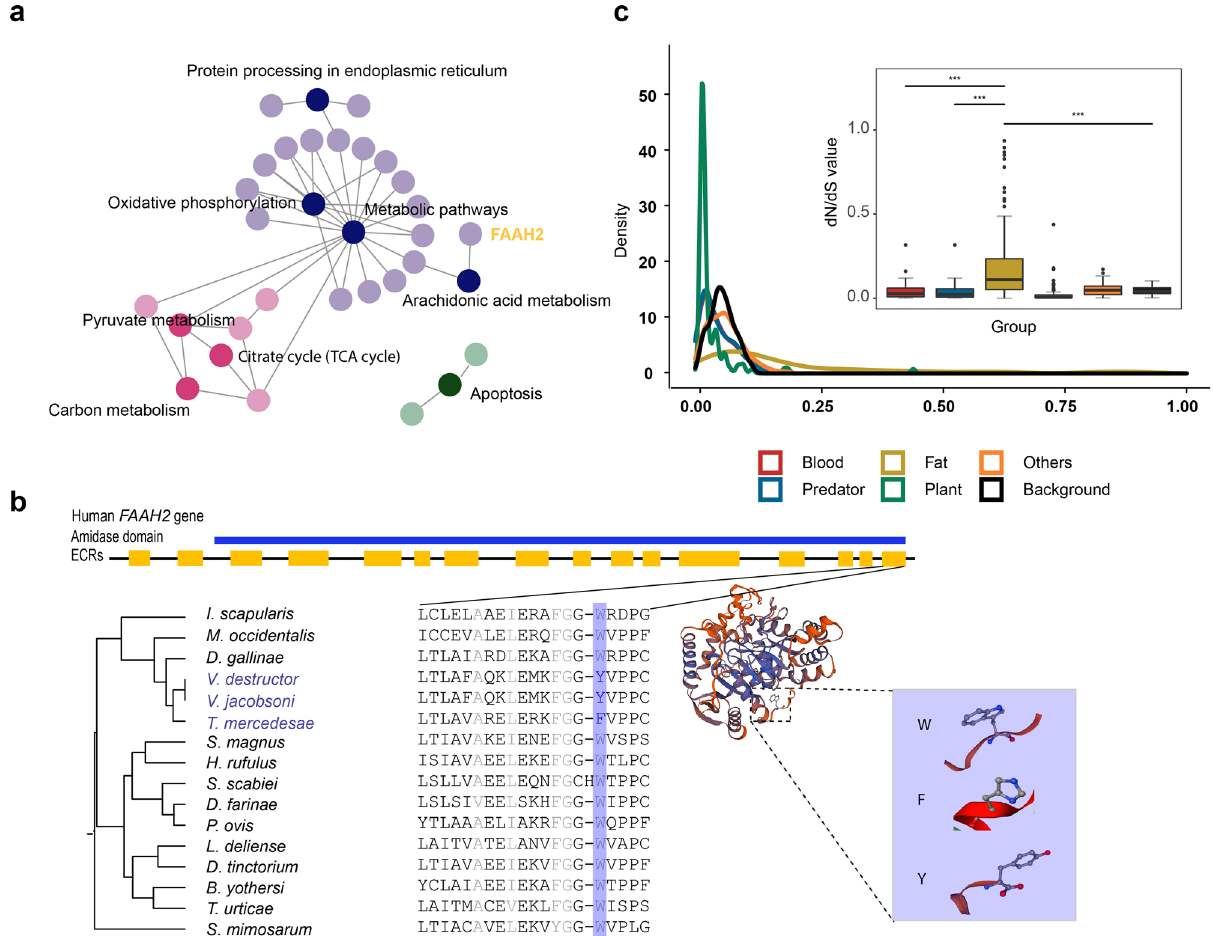
Fig. 6 PSG and dN/dS values of the lipid metabolism system. a KEGG pathway enrichment of the PSGs in the fat-feeding dietary group reveals that FAAH2 is involved in arachidonic acid metabolism. b Structural domains of the FAAH2 protein and comparison of the positively selected amino acid substitutions among the genomes. The site is W516F/Y, and all groups except the fat-feeding group show strict conservation of W amino acids. The structural domain annotation was derived from the NCBI database. c Density of dN/dS values of the lipid metabolism gene set in fi ve dietary groups and the background. A total of 122 genes related to the development of lipid metabolism were retrieved from the KEGG, and we calculated the dN/dS ratios on the branches connected to fat-feeding, blood-feeding, herbivorous, predatory, and other dietary groups with the two-ratio branch model (model 2) of PAML. Background dN/dS ratios were evaluated with a one-ratio branch model (model 1) of PAML. The distribution density and a box plot of dN/dS values (dN/dS<1) in different dietary groups are displayed. The mean dN/dS value on the branch of the fat-feeding group was signi fi cantly higher than that of the background and other groups (*** P < 0.01). Error bars represent standard deviation (SD). KEGG Kyoto Encyclopedia of Genes and Genomes, PSG positively selected gene, PAML phylogenetic analysis by maximum Identi fi cation of positively selected genes . A total of 9,306 gene families were html) were included for analysis. The branches were divided into fi ve groups with identi fi ed by OrthoFinder, and 4,546 single-copy orthologous genes were generated different dietary types. The dN/dS ratios of selected groups were calculated by the to perform positive selection analysis, which annotated at least 60% of the sixteen codeml program with the two-ratio branch model (model = 2) in PAML, and the genomes. The sequences of orthologous genes were aligned by MAFFT software dN/dS values of the background were detected with the one-ratio model (model = (version 7.455), and a gene tree was generated from the species tree based on the 0, NSsites = 0). The density distribution of dN/dS values and a violin plot of dN/dS remaining species. The branch-site model in PAML was used to detect PSGs along values for different dietary groups were generated. The dN/dS ratios were com- speci fi c lineages with model A (model = 2 and NSsites = 2). A likelihood ratio test pared with that of background data with Student ’ s t test. (LRT) was performed to compare model A (sites under positive selection in the foreground; fi x_omega = 0) with the null model (sites might evolve neutrally/ under purifying selection; fi x_omega = 1 and omega = 1) by the codeml program in PAML. The P values from the LRTs were evaluated via chi-square statistics, a false discovery rate (FDR) was calculated, and the cut-off was set to 0.1. Sites with a Bayesian empirical Bayes (BEB) posterior probability greater than 95% were selected as positively selected sites in PAML. KEGG and GO enrichment analyses of PSGs were performed by KOBAS 3.0 68 with cut-offs of a P value < 0.05 in Fisher ’ s exact tests and an FDR-corrected P value < 0.1. Drosophila melanogaster genes were selected as the background set. Bubble diagrams of signi fi cantly enri- ched KEGG and GO terms were generated using the R ggplot package. Evolutionary rate of fat metabolism . To investigate the evolutionary rate of fat metabolism among mites with different diets, 122 genes involved in lipid meta- bolism from the KEGG database (http://www.genome.jp/kegg/catalog/org_list.